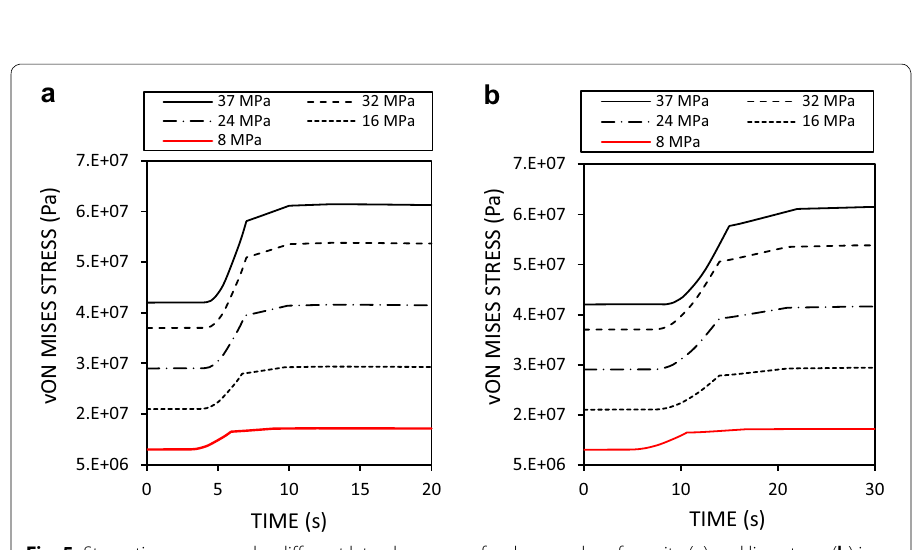
Fig. 5 Stress-time curve under different lateral pressures for dry samples of granite ( a ) and limestone ( b ) in Point A (x 1.5 mm, y 50 = =